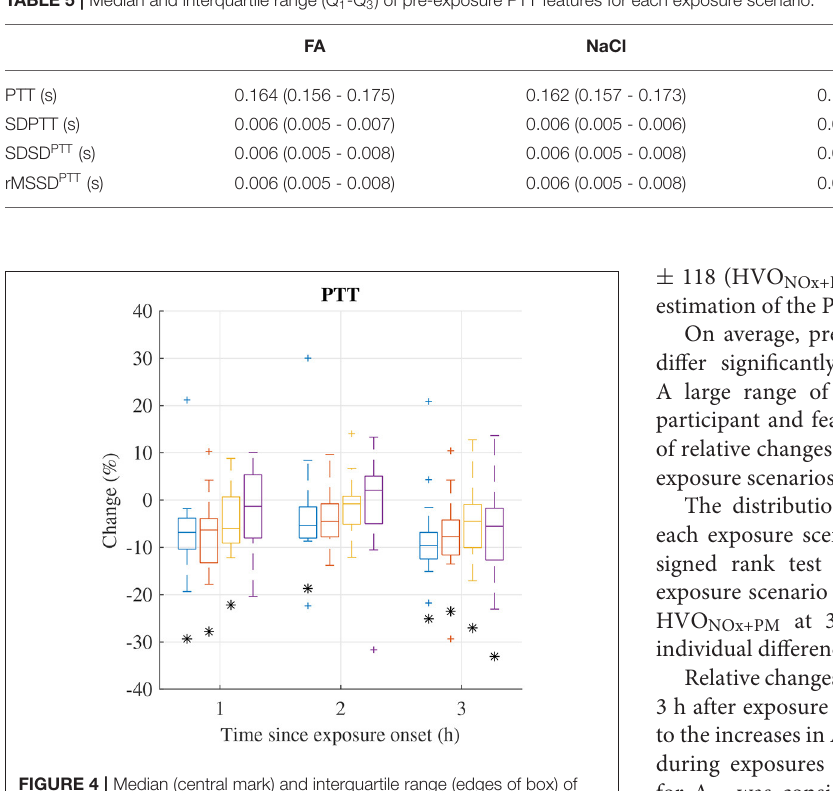
FIGURE 4 | Median (central mark) and interquartile range (edges of box) of change 1 ( F i ) t of mean PTT during exposure scenario FA (blue), NaCl (red), HVO NOx (yellow), and HVO NOx+PM (purple). Whiskers extend to 1.5 times the interquartile range and values outside this interval are marked by “+.” 1 ( F i ) t significantly different from zero according to the Wilcoxon signed rank test (p < 0.05) are marked by